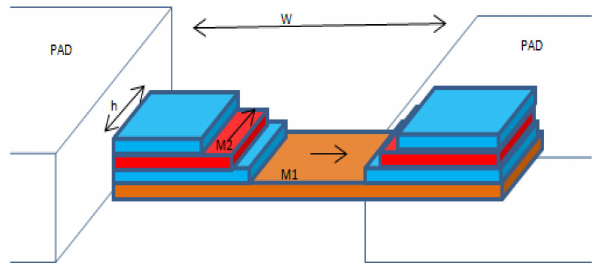
Figure 4. Schematic of a spin valve sensor element. M1 is the free ferromagnetic layer, and M2 is the pinned ferromagnetic layer by Freitas et al. [17].